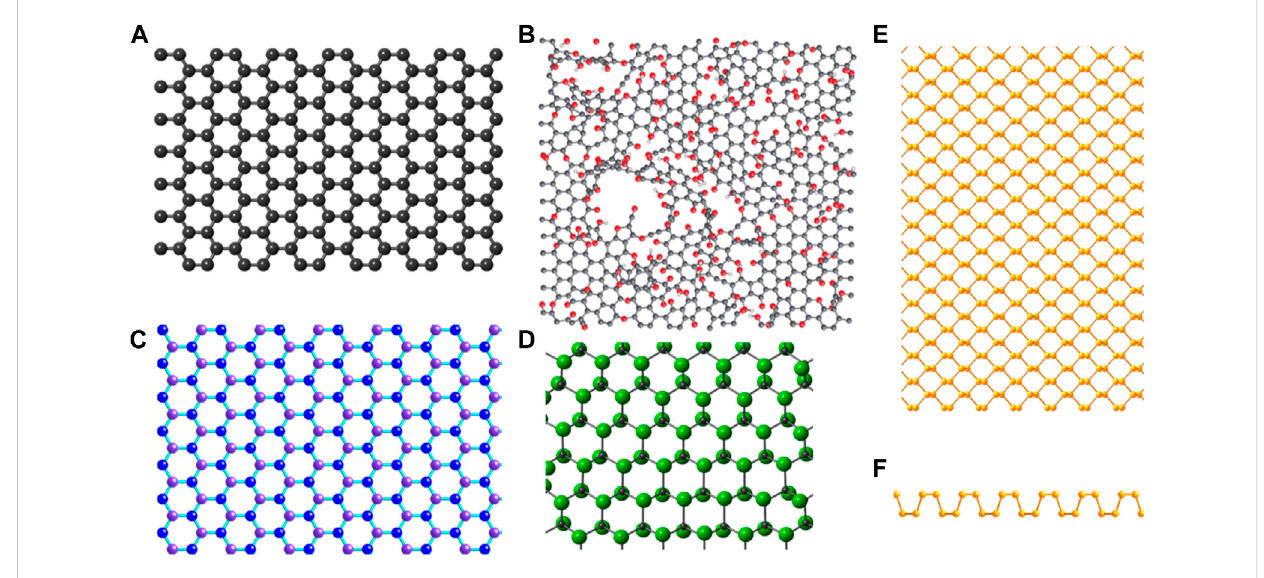
FIGURE 1 The structures of graphene family nanomaterials: (A) graphene, (B) graphene oxide, (C) hexagonal boron nitride, B shown in purple, N in blue, (D) fl uorographene, F shown in green, C in gray. Fluorine atoms are distributed in one of two ways on the graphene surface in fl uorographene, dubbed the “ chair-type ” and “ boat-type conformations. ” Depicted here is fl uorographene in the more energetically favorable chair-type conformation. (E) Phosphorenetopand (F) sideviews. (B) ReprintedwithpermissionfromMacmillanPublishersLtd.:NatureChemistry, (A) .Bagri, (C)